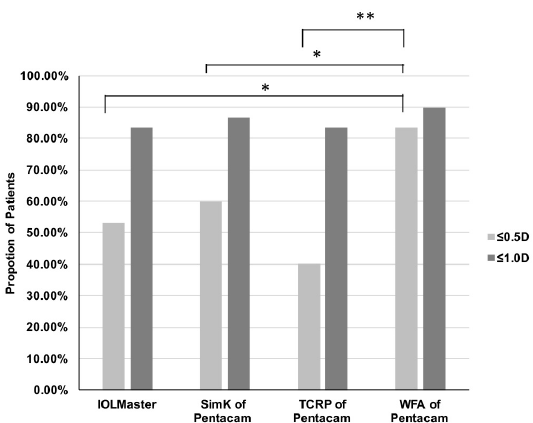
Figure 4. Proportion of eyes with absolute corneal astigmatism prediction errors of ≤ 0.5 D or ≤ 1.0 D, according to the measurement mode. The proportions were highest using the Pentacam WFA mode. The proportions of eyes with a prediction error of ≤ 0.5 D were significantly different ( χ 2 test, p = 0.007; WFA vs. IOLMaster, p = 0.012; WFA vs. SimK, p = 0.045; WFA vs. TCRP, p = 0.001). SimK, simulated keratometry; TCRP, total corneal refractive power; WFA, wavefront aberration. * p < 0.05, ** p < 0.01.